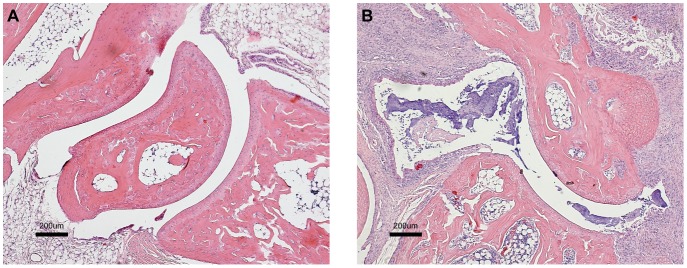
Histology of paw joints from BSSL-KO and BSSL-WT mice.Hematoxylin and eosin staining of hind limb sections from (A) BSSL-KO and (B) BSSL-WT mice taken at day 57 after initial injection with rat CII. The joint of BSSL-KO mice has normal histological appearance without cellular infiltration whereas the joint of BSSL-WT mice shows signs of cartilage destruction and significant inflammatory cell infiltration. Images shown are representative of those obtained from five mice in each group. Original magnification ×4.